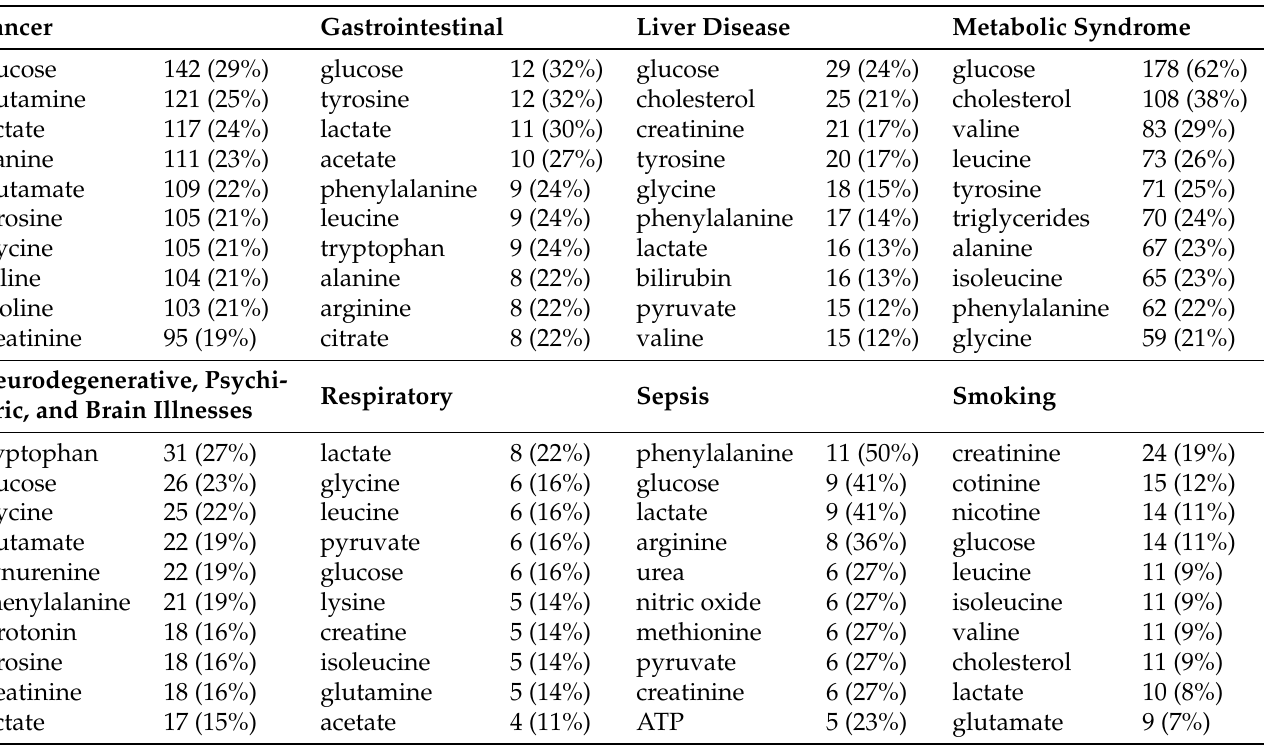
Table 4. Top ten metabolites reported for each trait in the metabolomics corpus. The number of articles that report the metabolite are given including the percentage of the total. The total number of articles in each category can be found in Table